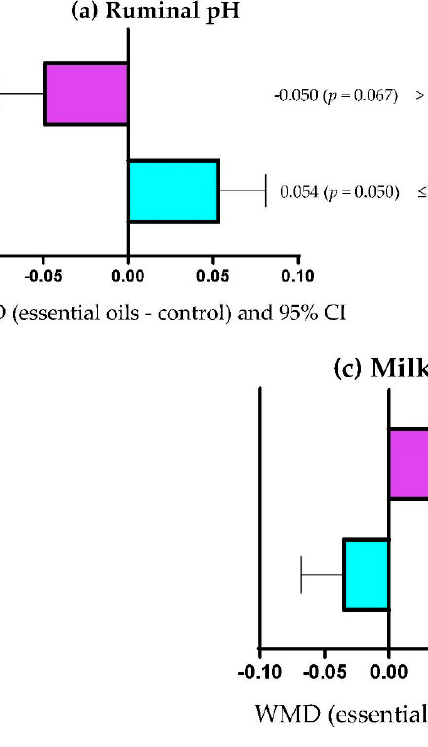
Figure 2. Subgroup analysis (subgroup = supplementation period (days)) of the effect of essential oils on the diet of the small ruminants; WMD = weighted mean differences between essential oil treatments and control.